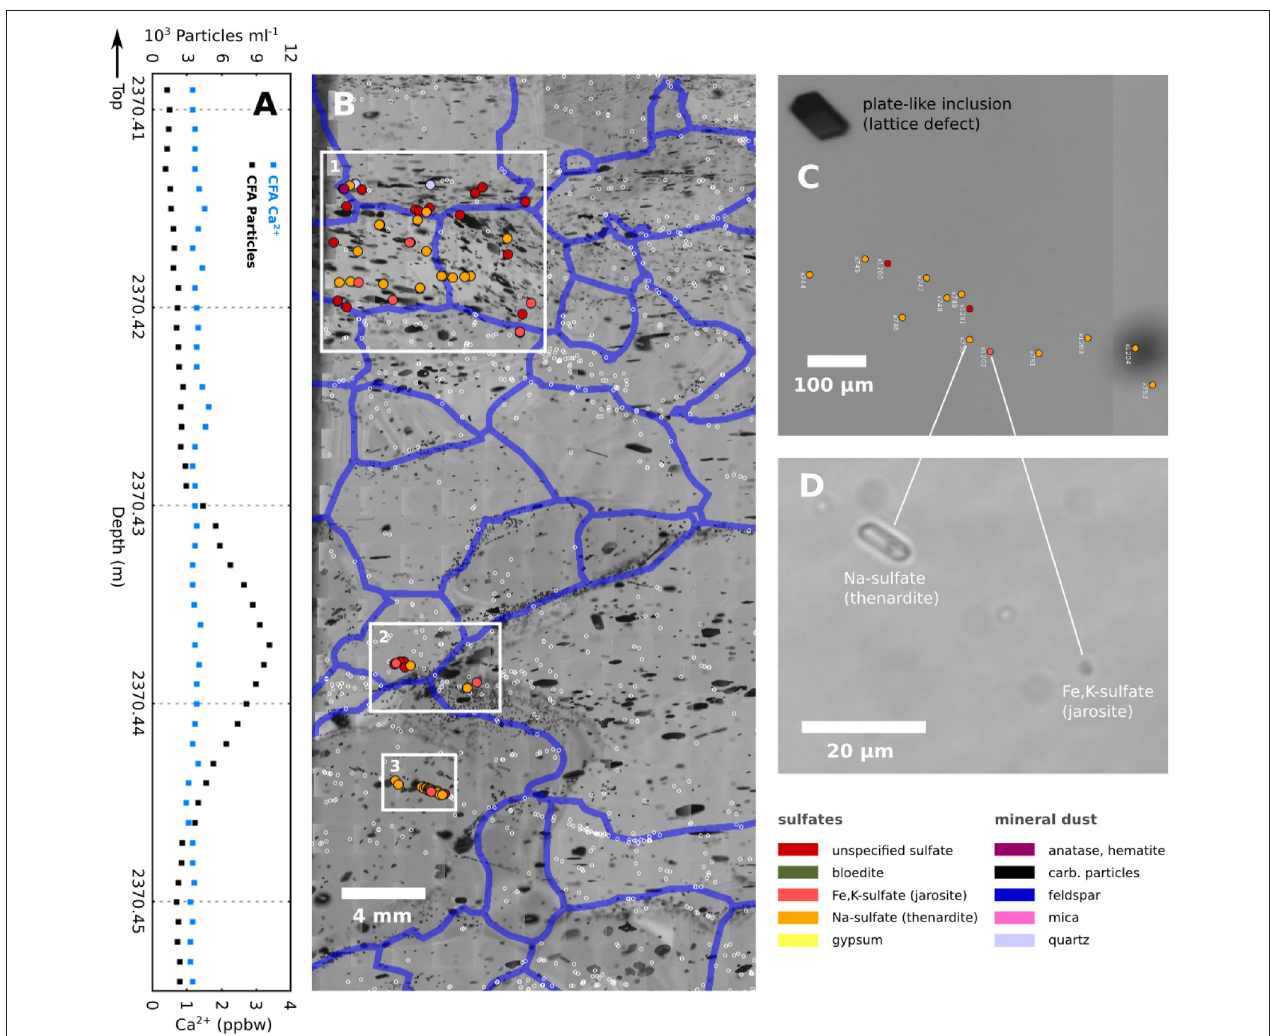
FIGURE 4 | Detail of section 2371-4 (2370.408–2370.455 m): (A) high resolution CFA profile showing Ca 2 + concentration and number of insoluble particles. (B) Impurity map with three rectangular areas of interest. White circles represent positions of individual micro-inclusions presented in Eichler et al. (2017). Colored circles indicate micro-inclusions analyzed with the Raman system. Blue bands indicate positions of grain boundaries at the focus depth of the micro-inclusions. Black objects in the image are effects of ice relaxation: small elliptical micro-bubbles which tend to form close to grain boundaries and larger hexagonal planar lattice defects often called the plate-like inclusions. (C) detail of area 3 with a chain of micro-inclusions. A plate-like inclusion (black, upper left corner) can serve as a marker of the crystallographic lattice orientation. (D) detail of two micro-inclusions from area 3. The sodium sulfate particle (left) exhibits an exceptionally large size. Its elongation direction seems to coincide with the basal plane of the ice